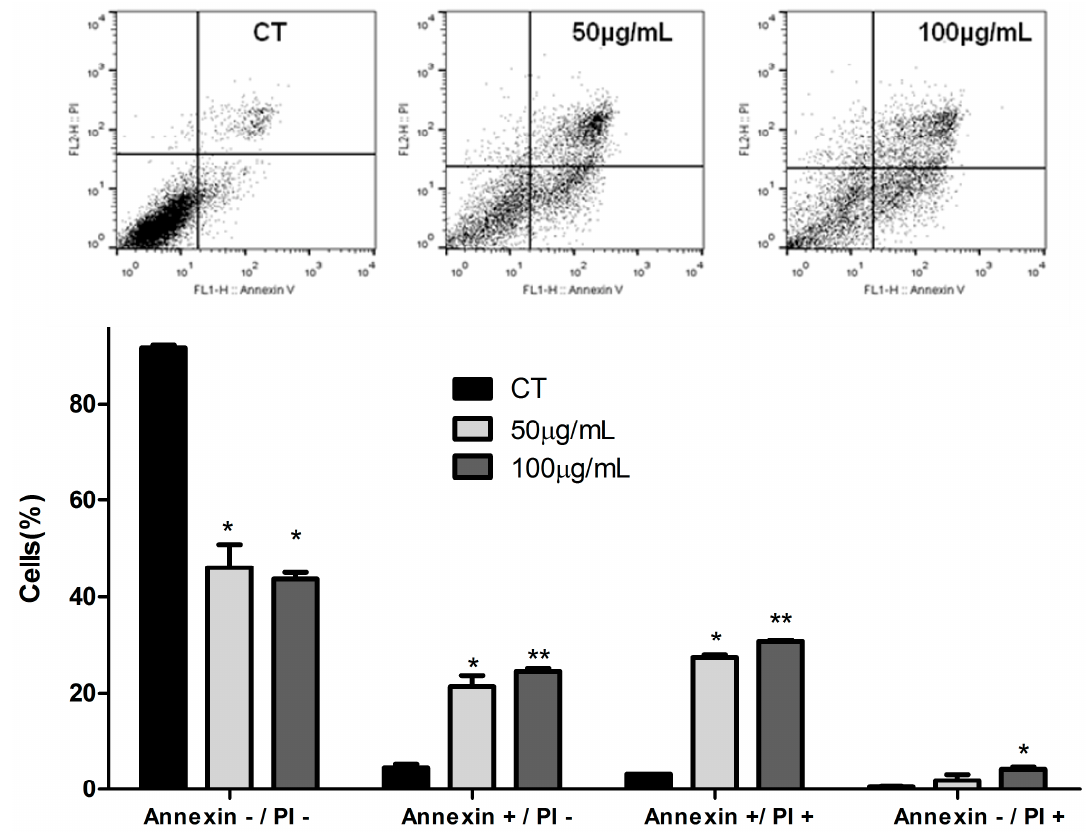
Figure 3. Effect of açai seed extract (ASE) on stages of death process in human lung carcinoma cells (A549) after 48 h. Results are expressed as a percentage of total cells. The experiment is expressed as mean ± standard deviation, with significant differences between untreated cells (CT) and treated with açai seed extract (ASE) (50 and 100 µg/mL) were compared by One-way ANOVA with the post-test of Tukey (* p < 0.05, ** p < 0.01).